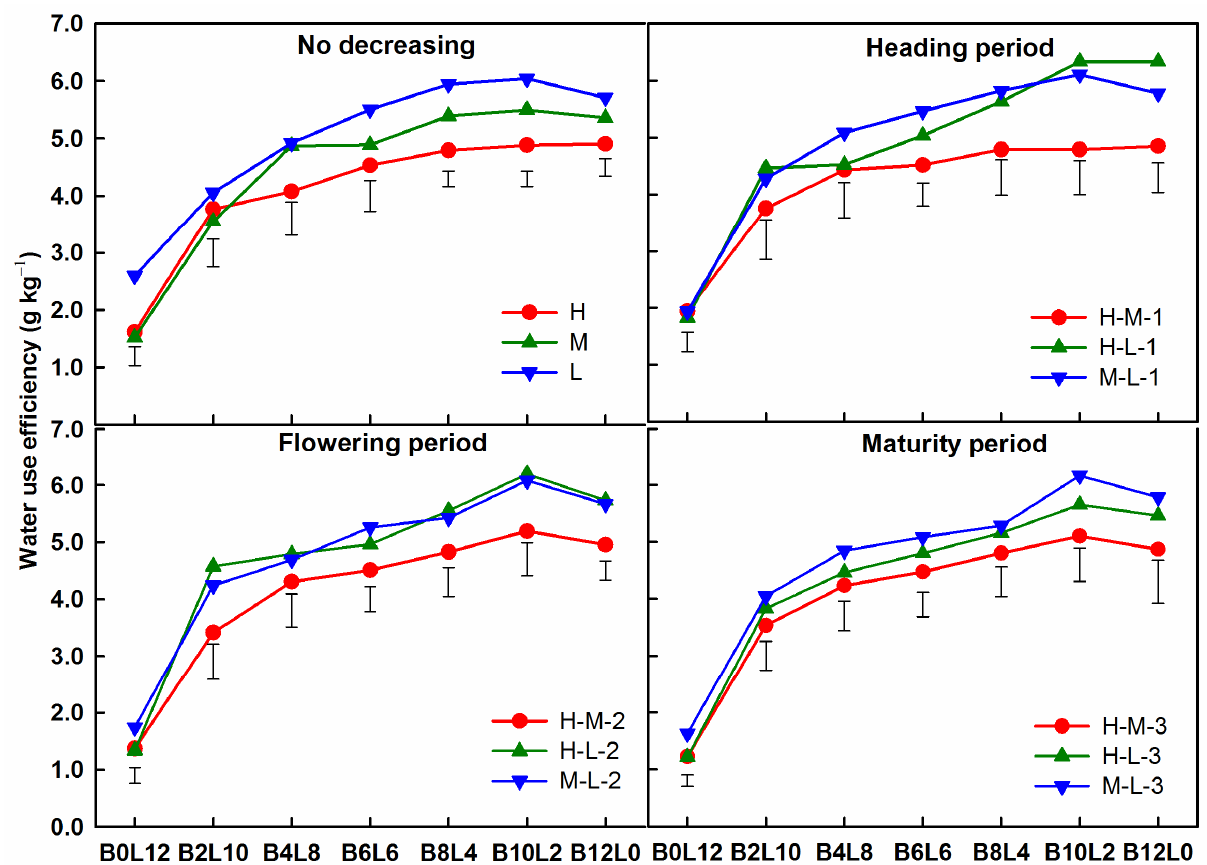
Figure 6. Water use efficiency (WUE) of B. ischaemum (B) and L. davurica (L) under soil water decreasing treatments in their mixtures. Vertical bars represent LSD 0.05 values.